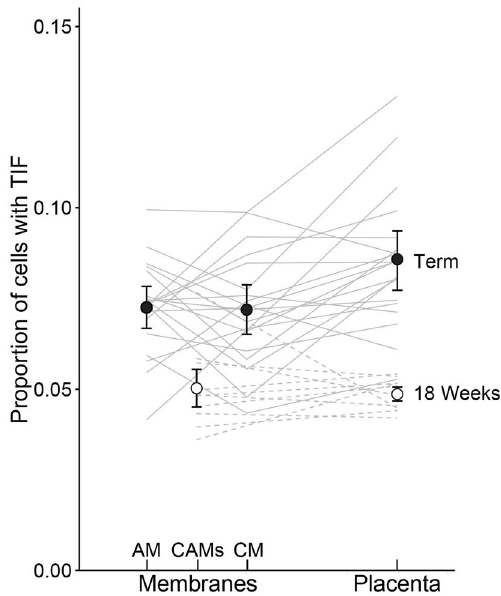
Figure 2. Proportion of cells with telomere dysfunction induced foci (TIF) at 18-weeks of gestation (n = 10) and at term (n = 18), in the placenta and the chorioamniotic membranes (CAMs). Note that at 18 weeks the CAMs could not be separated and hence the measurements are for the chorionic membrane (CM) and amniotic membrane (AM) combined, i.e., CAMs. Lines connect measurements in different tissues from the same donor, and dots show means ±